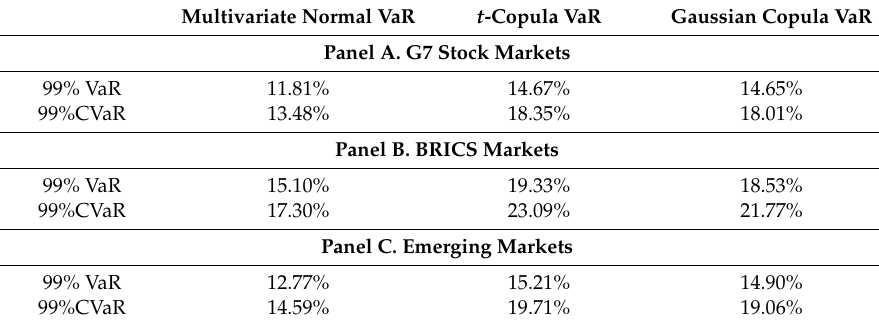
Table 2. Value-at-Risk VaR and Conditional VaR (CVaR)